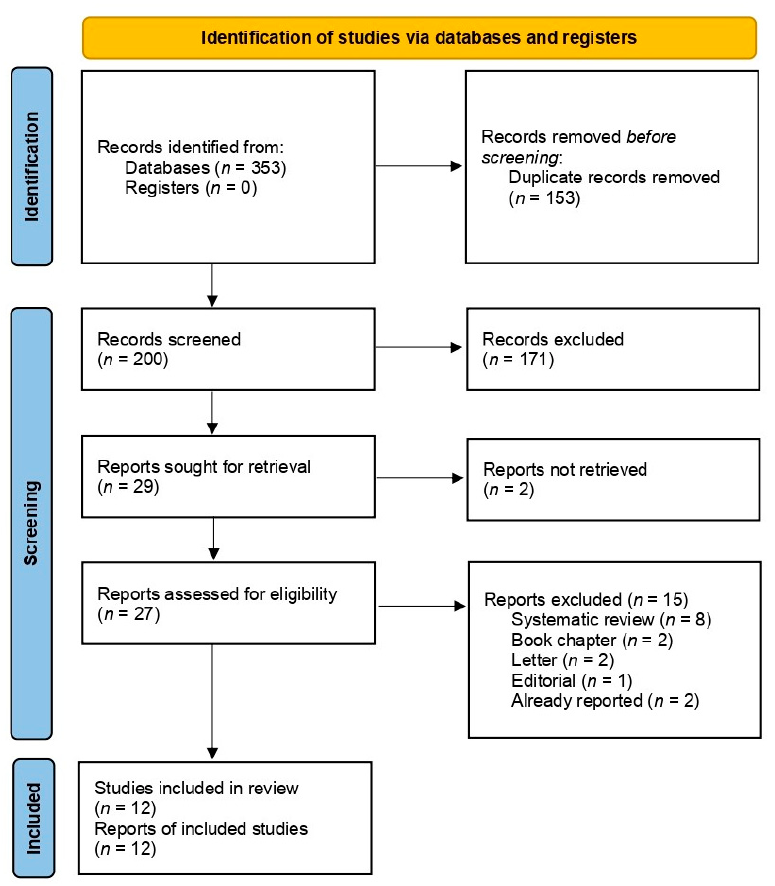
Figure 1. PRISMA flowchart of the study selection process.